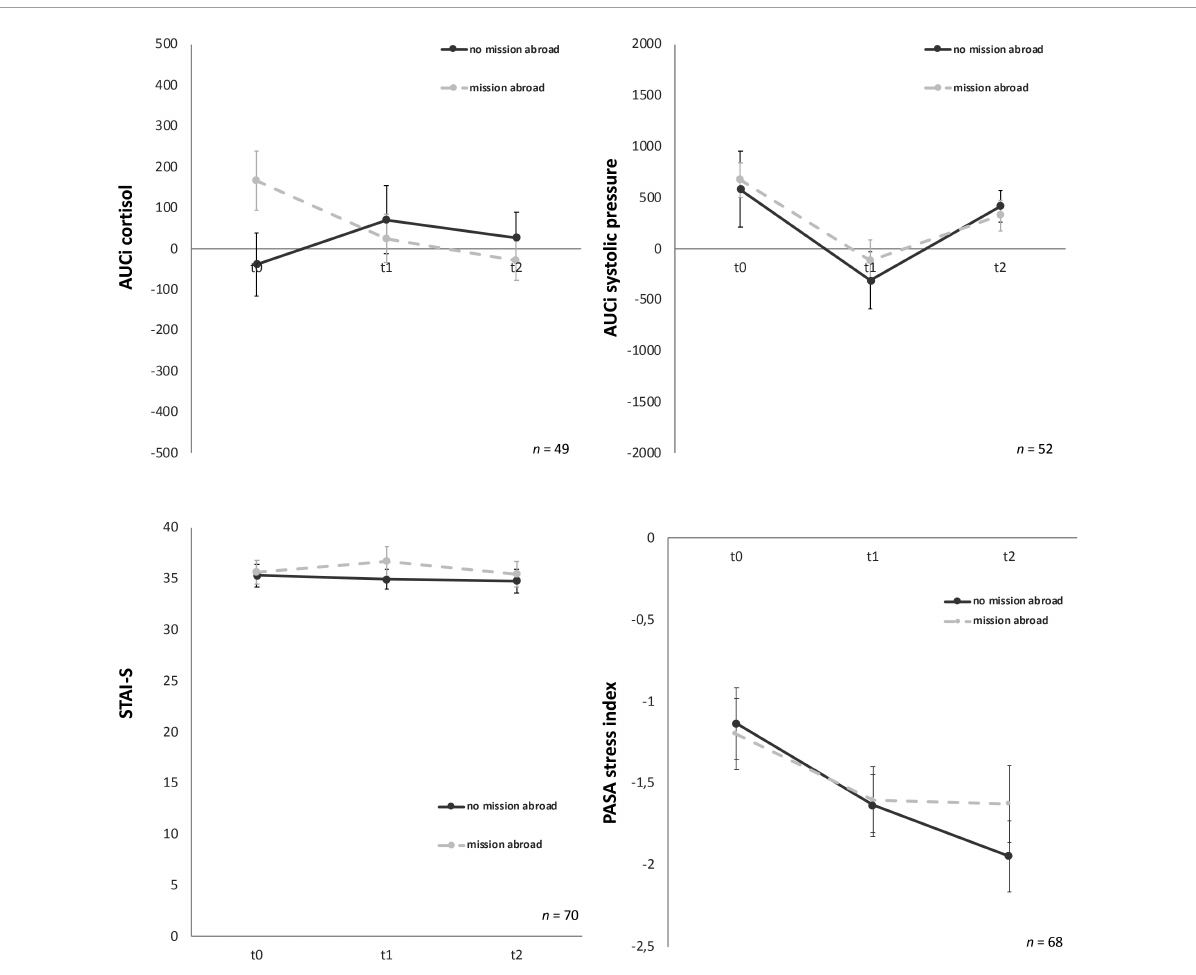
FIGURE6 Stress response of cortisol, systolic pressure, state-trait-anxiety inventory: before and after mental stress task (STAI-S) and primary appraisal secondary appraisal (PASA) for the three time points (t0, t1, t2). Y-axis values: AUCi, area under the curve with respect to increase for cortisol (nmol/l) and systolic pressure (mm/Hg). STAI-S before mental stress and PASA during Trier Social Stress Test for groups (TSST-G); values are means ( ±